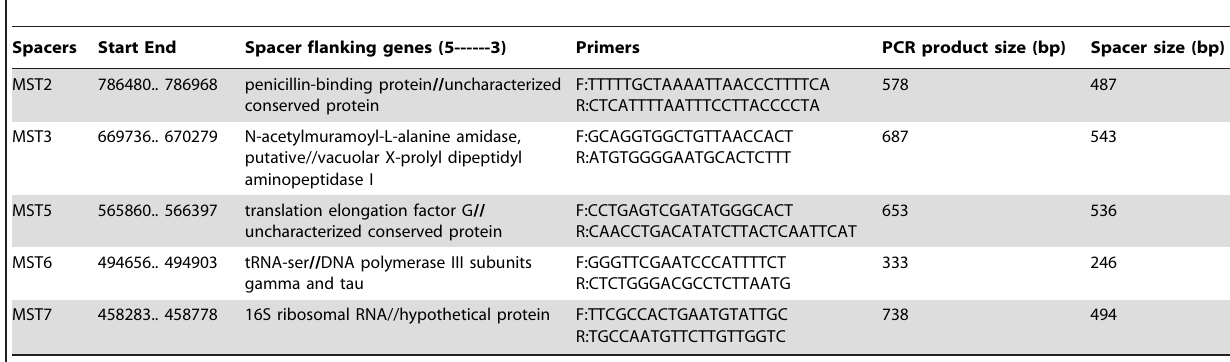
Table 1. List of primers and genes flanking five intergenic spacers herein studied in relapsing fever Borrelia .